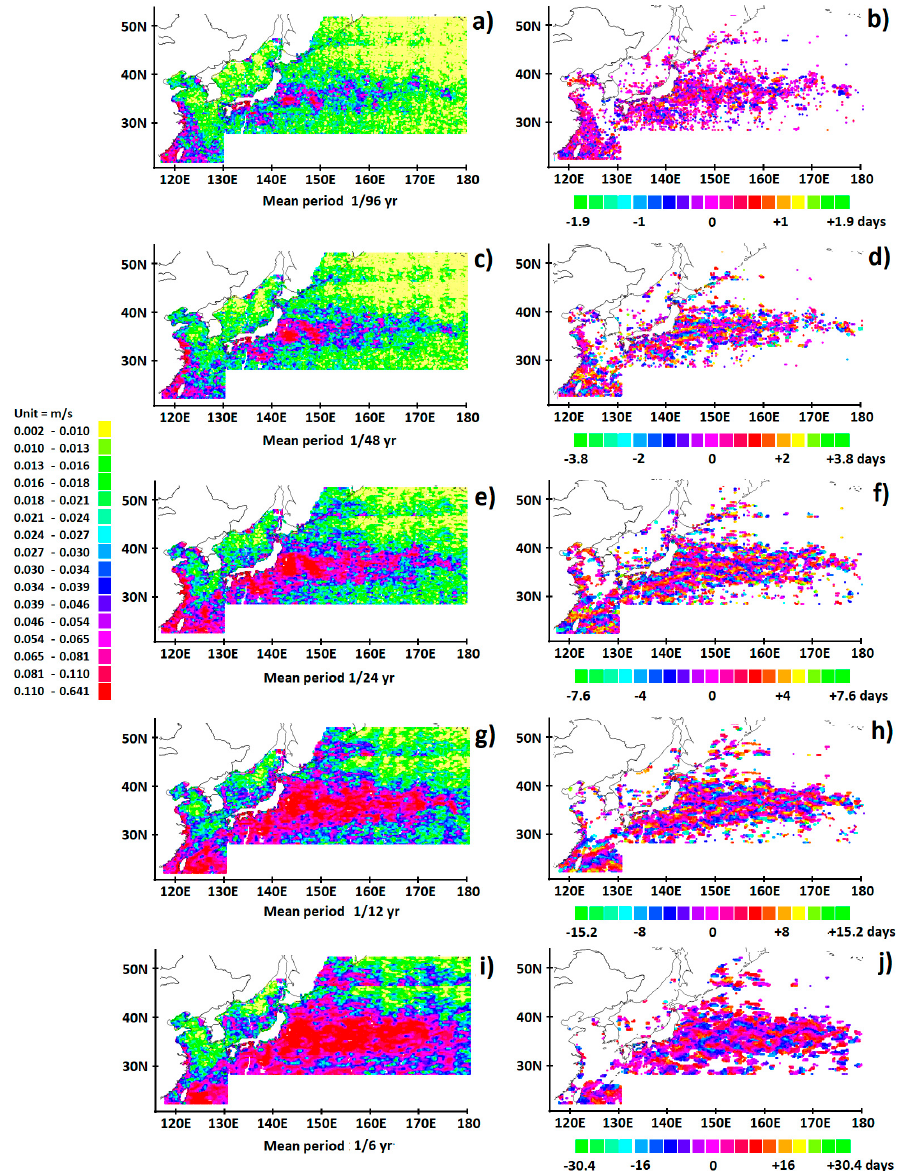
Figure 4. Same as Figure 3 for the amplitude ( a , c , e , g , i ) and the phase ( b , d , f , h , j ) of the zonal geostrophic current U oriented to the east when the time lag is zero. Same data sources as in previous figures.